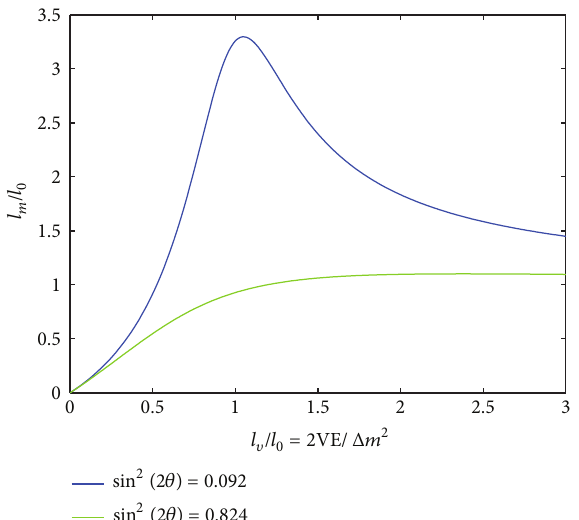
Figure 4: Dependence of the oscillation length in matter in units of the refraction length on neutrino energy for two different mixing angles in